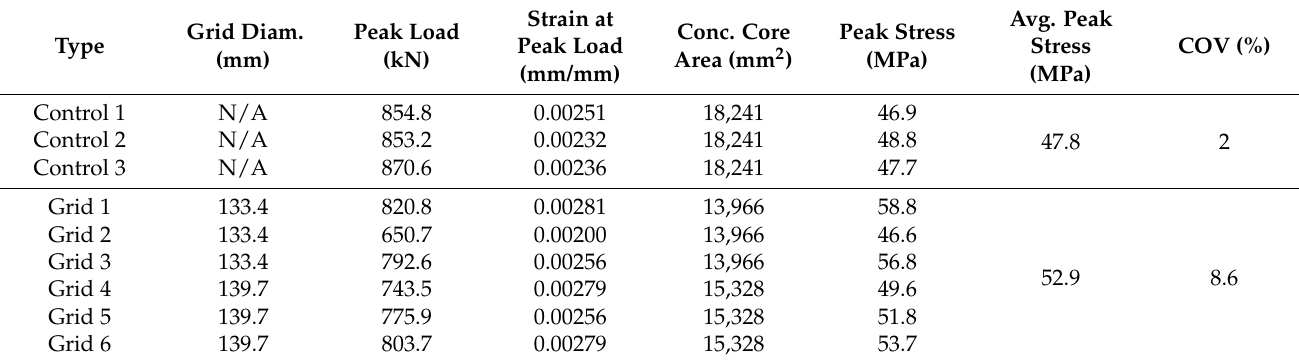
Table 2. Experimental results for peak load, strain at peak load, and peak stress for control and CFRP grid specimens [3]. Grid Type